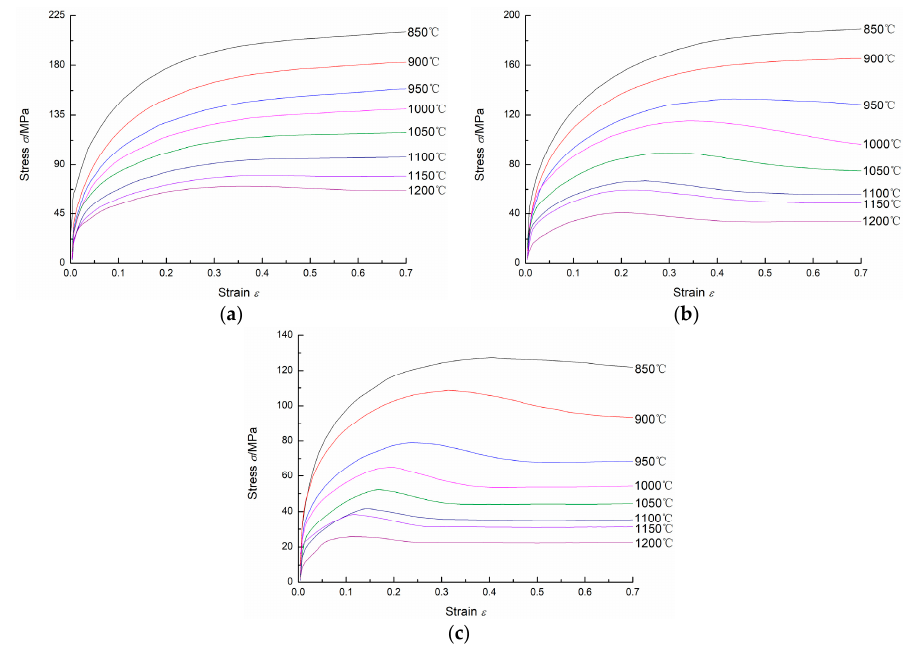
Figure 2. Flow stress curves of the 20Mn5 steel under strain rates of: ( a ) 1/s; ( b ) 0.1/s; ( c ) 0.01/s.